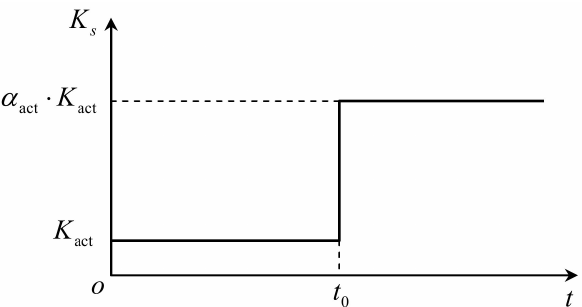
Figure 2. Variation of the spring constant with time during the morphing